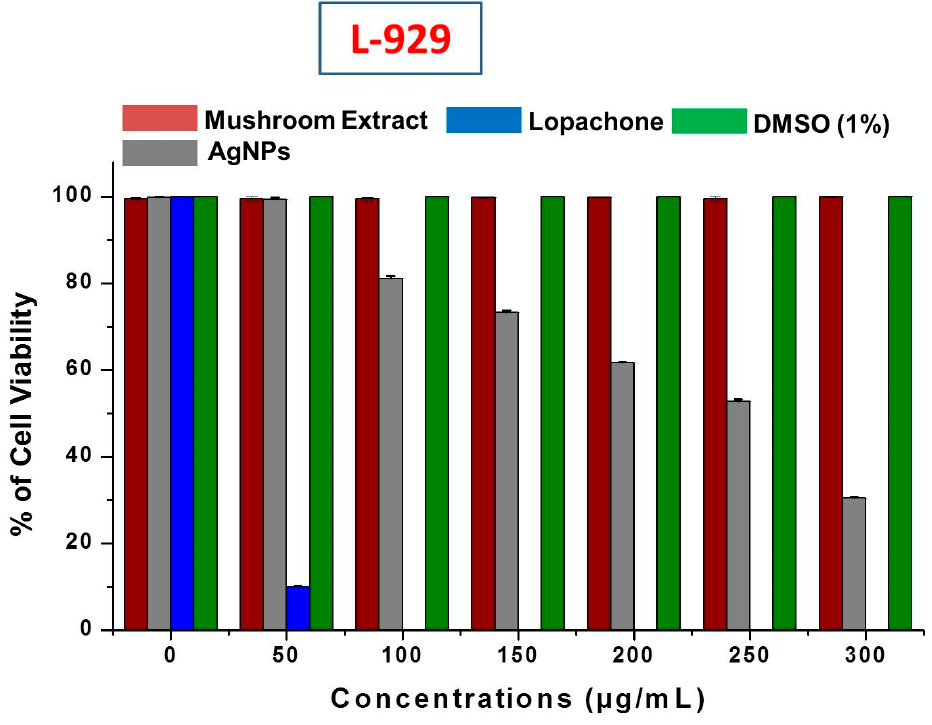
Figure 9. Cytotoxic effect of silver nanoparticles (AgNPs) on L-929 normal fibroblast cell lines.